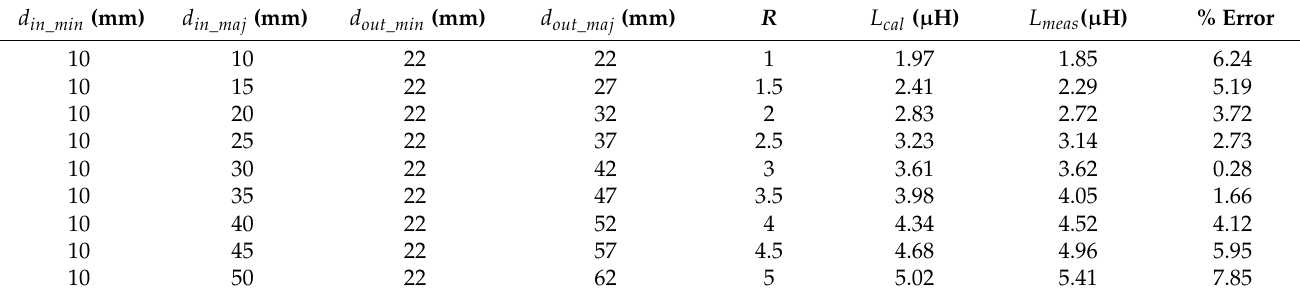
Table 10. Key results of elliptical planar inductors for varying major-to-minor ratios when trace separation ( S ) and trace width ( W ) were kept constant at 300 µ m.